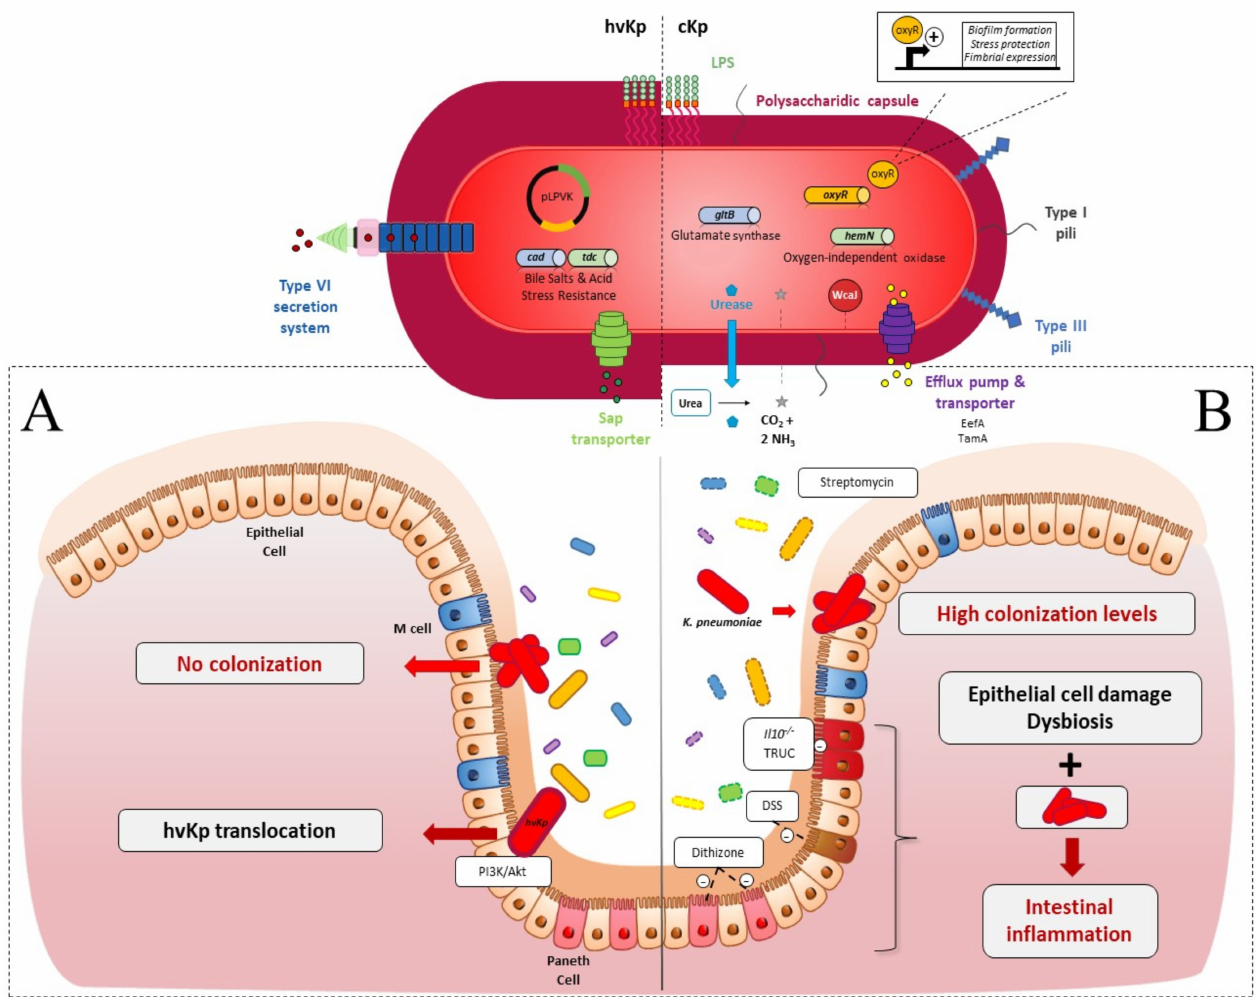
Figure 1. K. pneumoniae in the gastrointestinal (GI) tract in an in vivo murine model ( A ) In healthy immunocompetent mice: (i) cKp (red oval, fine capsule) is not able to colonize the intestinal epithelium due to the presence of upright endogenous microbiota (yellow, blue, green and purple ovals, full line); (ii) hVKp (red oval, hypermucous) deploys many virulence factors. Type VI Secretion System (T6SS): to counteract the microbiota barrier; transporters of antimicrobial peptides and amino-acids (Sap, Tdc) and enzymes with lysine decarboxylase activity (Cad). Hypercapsular phenotype due to the presence of pLVPK plasmid (black circle) protects the pathogen against the host immune reaction. HvKp use the PI3k/Akt pathway to cross the epithelial barrier. ( B ) In intestinal dysbiotic mice: Dysbiosis (yellow, blue, green and purple ovals, dotted line) chemically induced (streptomycin, Dextran Sodium Sulfate (DSS), dithizone) or endogenous to immune-deficient murine models ( Il10 − / − , T-bet − / − Rag2 − / − ulcerative colitis (TRUC)) allows the implantation of cKp. Gut colonization by K. pneumoniae associated with intestinal epithelium damage and dysbiosis enhanced the inflammatory state. Essential cKp colonization factors are related to capsule synthesis (WcaJ, red circle), metabolism advantage (urease, oxidase, and glutamate synthase) (blue diamond, blue and green cylinder), GI stress resistance (EefA, TamA, OxyR,) (purple, yellow cylinder) and surface cell adhesion (Type 1 and 3